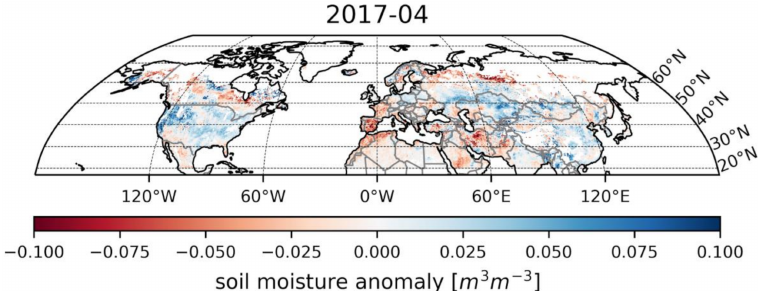
Figure 1. Soil moisture anomalies of European Space Agency (ESA) Climate Change Initiative (CCI) soil moisture (SM) COMBINED v04.7 for April 2017 with a climatology based on the period